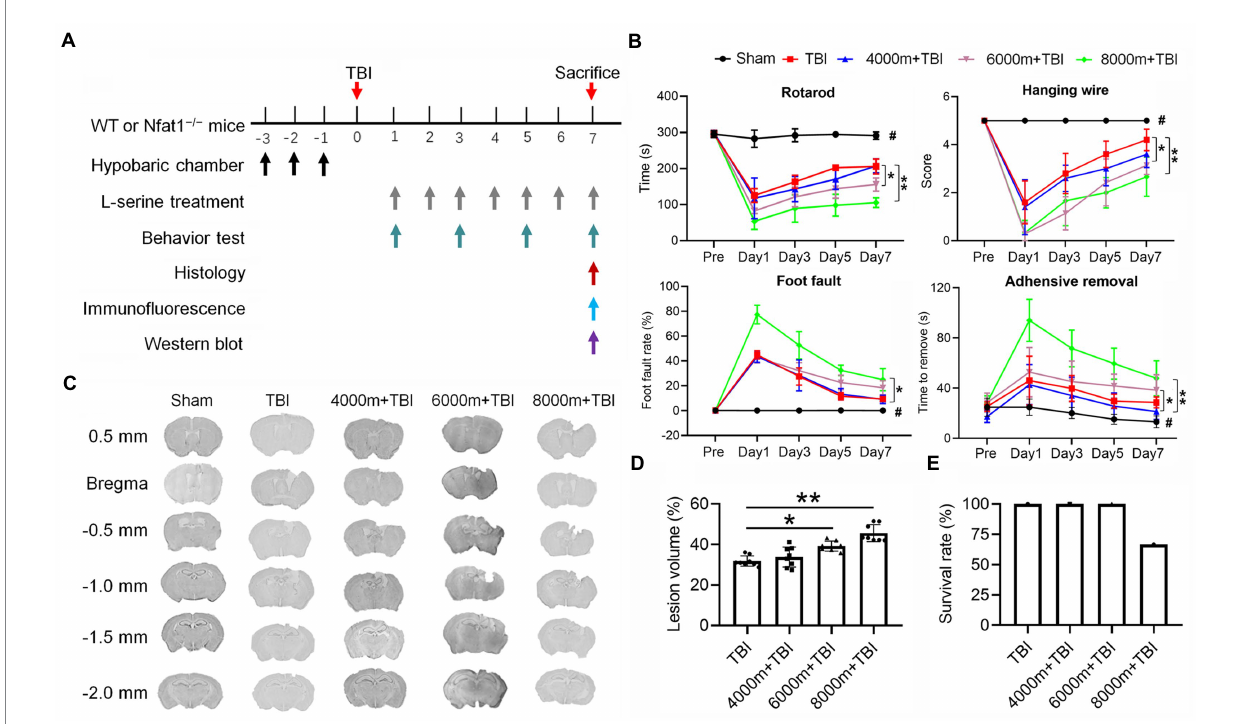
FIGURE 1 Effects of different altitudes on neurobehavioral function, cerebral gray matter and cerebral white matter in mice following TBI. (A) Temporal schematic of the experimental protocol and the observation time points. (B) Effects of different altitudes on neurobehavioral function in mice ( n = 7–8). (C) Coronal section of brain slices from bregma 0.5 mm to − 2.0 mm, showing the lesion brain tissue at different altitudes. (D) Quantification of the lesion volume ( n = 8). (E) Effect of TBI at different altitudes on the survival rate of mice ( n = 8). * p < 0.05, ** p < 0.01 versus the indicated group; # p < 0.01 versus other